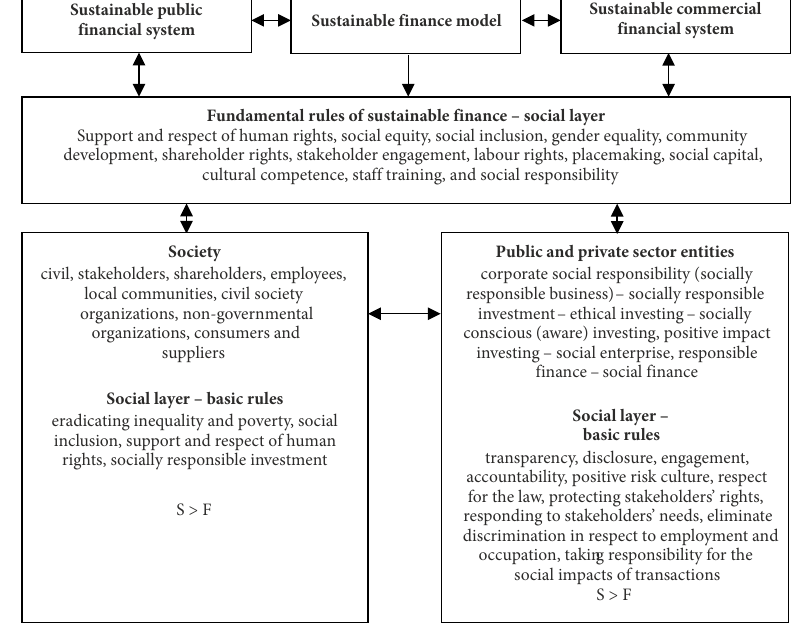
Figure 7. Triple layered sustainable finance model – social perspective